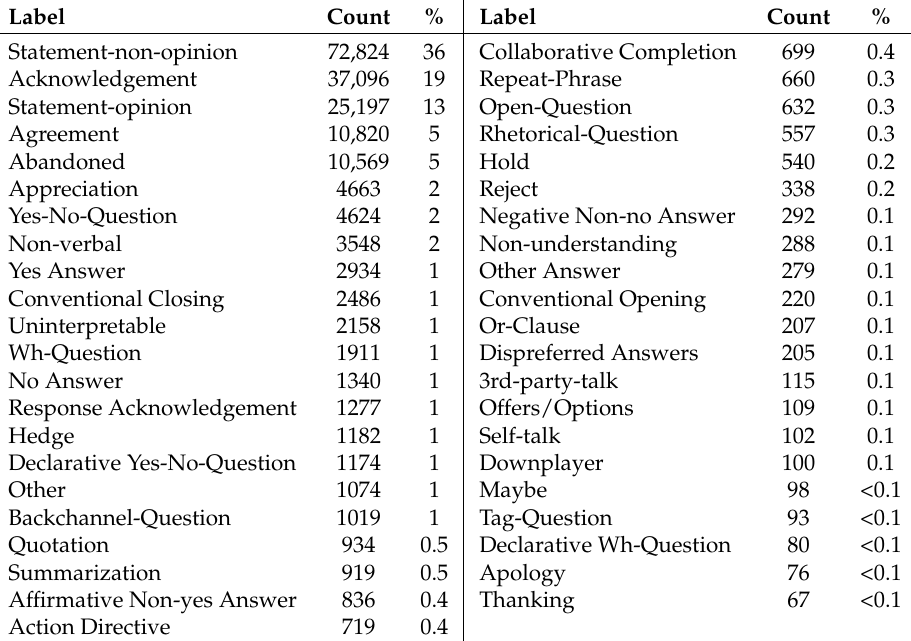
Table 1. Label distribution in the Switchboard Dialog Act Corpus (SwDA) [11].